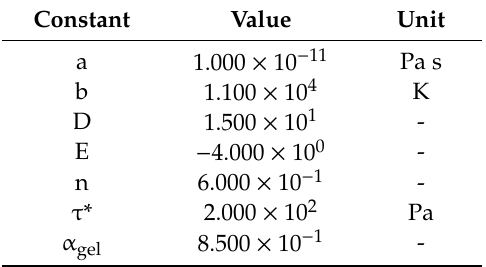
Table 3. Cross–Castro–Macosko viscosity model constants.